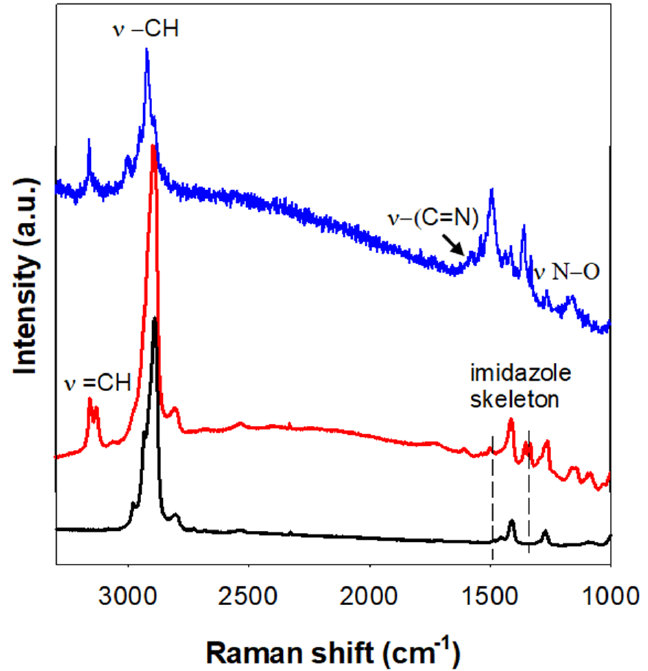
Figure 5. Raman spectra of Cl-EtPMO (black line), Im-EtPMO (red line), and Im-EtPMO-Co (blue line).